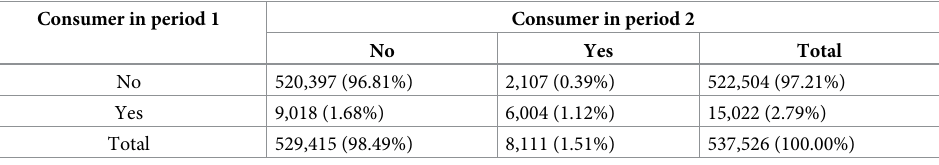
Table 2. Mc Nemar test regarding changes in prevalence consumptions.